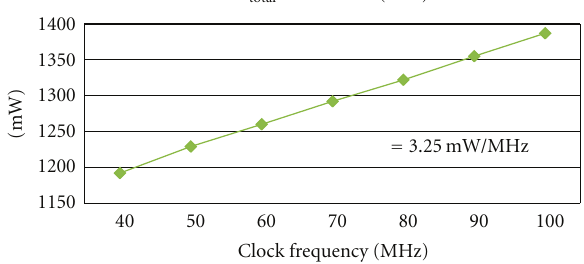
Figure 17: Impact of the clock frequency to the energy consump- tion of a uniprocessor design on a